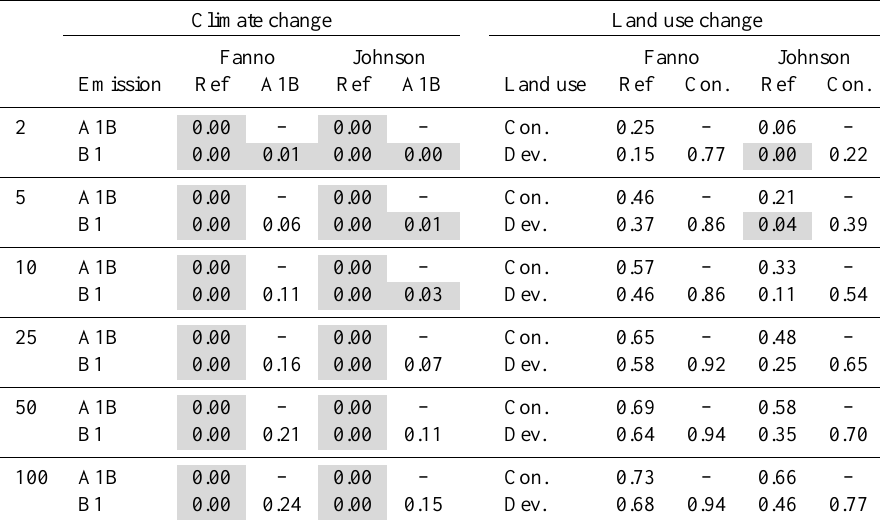
Table 3. t -test result of comparison between flood frequency change by GHG emission scenarios and land use change scenarios. Shaded value indicates significant p -value at the 95% confidence level.